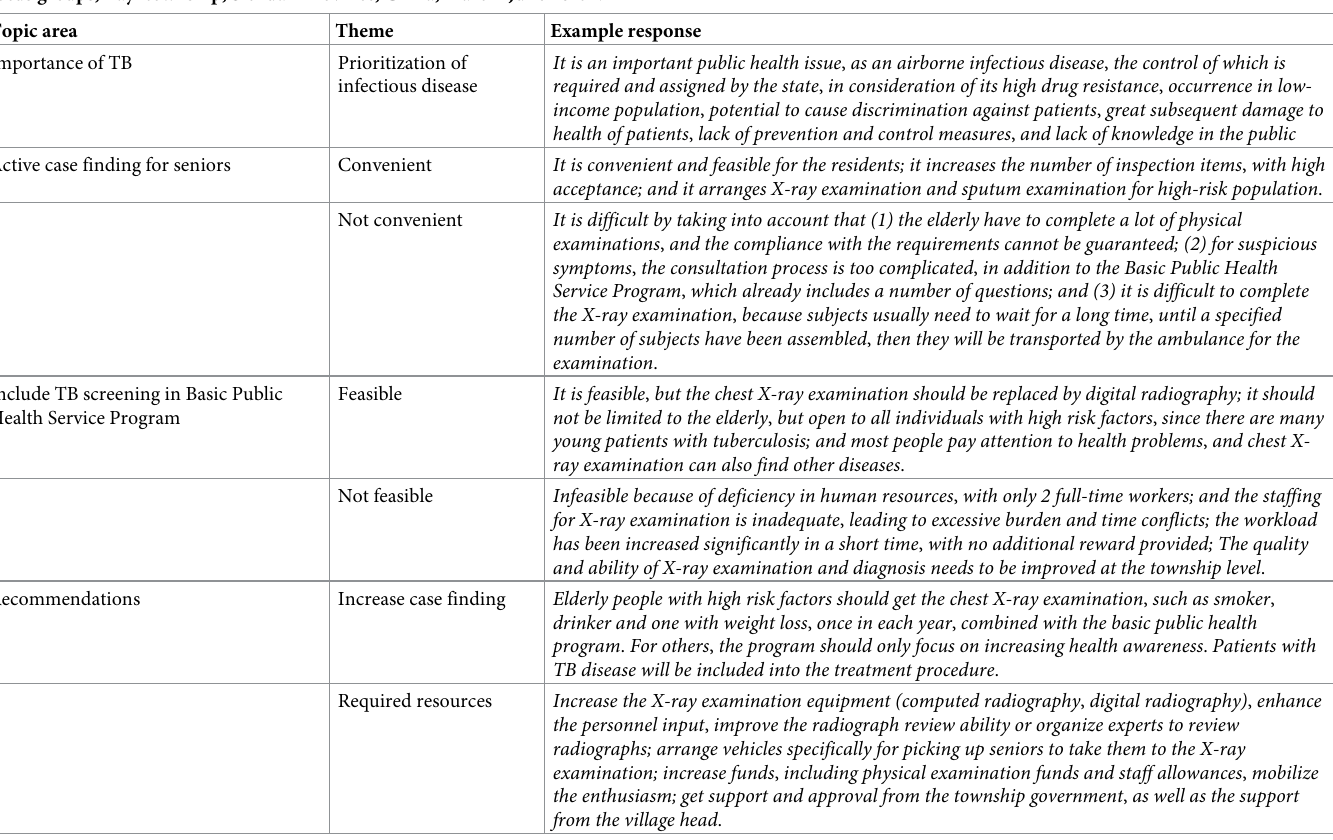
Table 4. Feedback from public health staff and health care workers on active case finding among seniors aged � 65 years captured through in-depth interviews and focus groups, Bayi township, Sichuan Province, China, March–June 2017 �